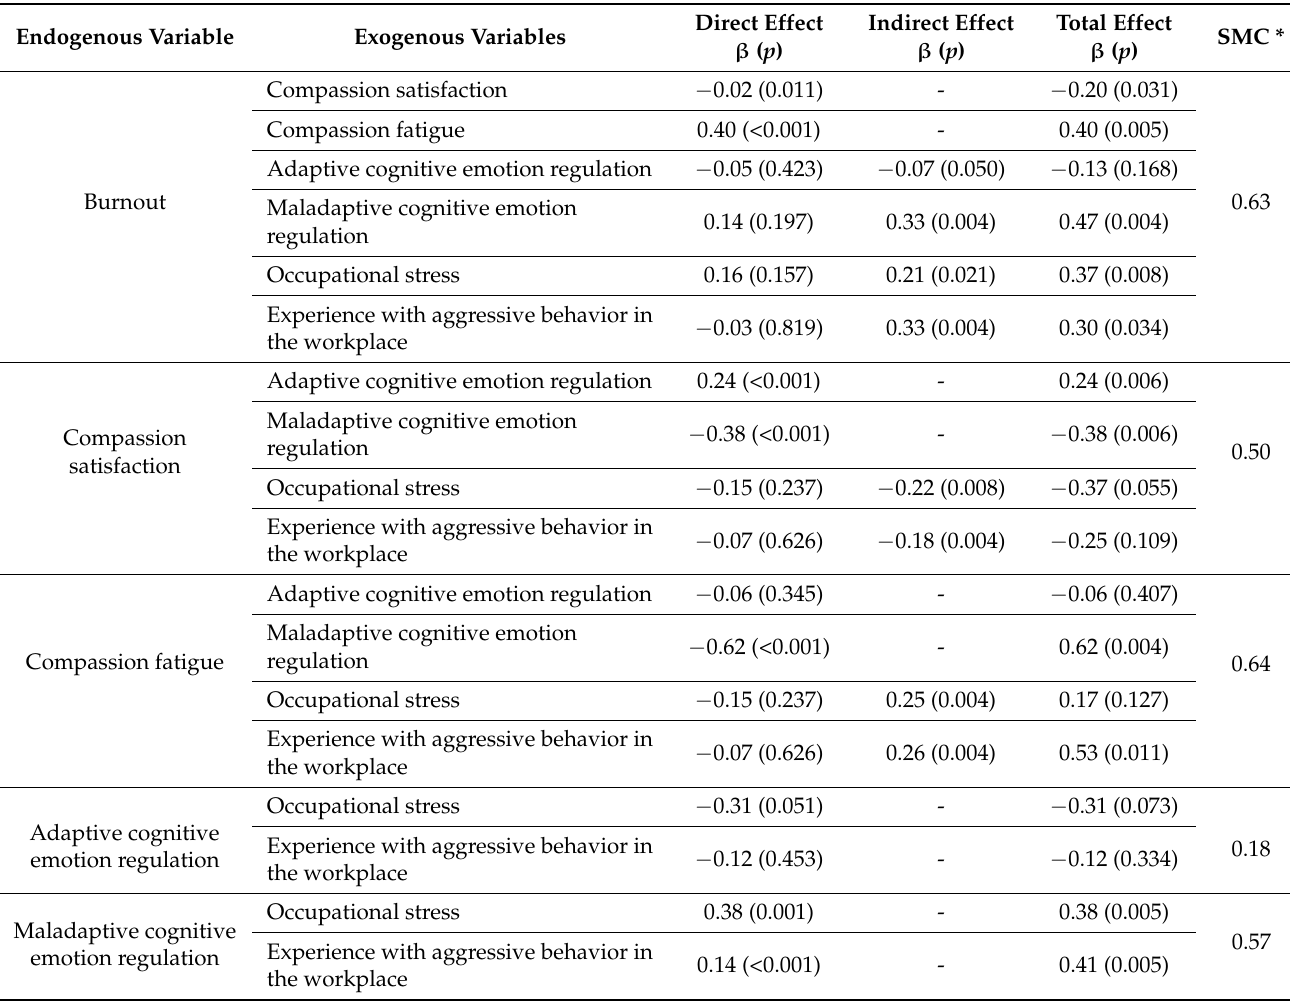
Table 3. Effect coefficient for hypothetical